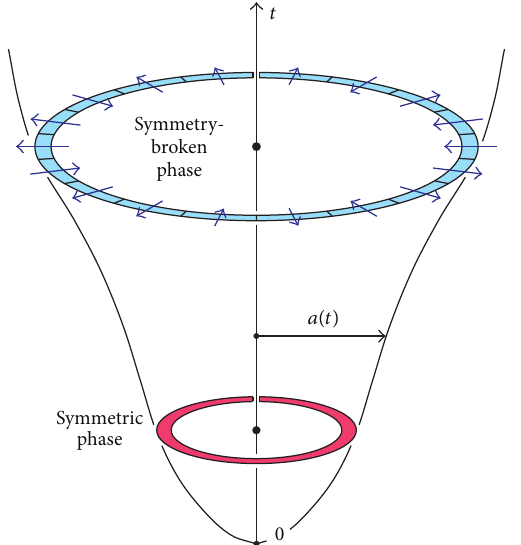
Figure 5: Sketch of the phase transition in 1D FRW cosmological model (the physical distance is measured along the circles).